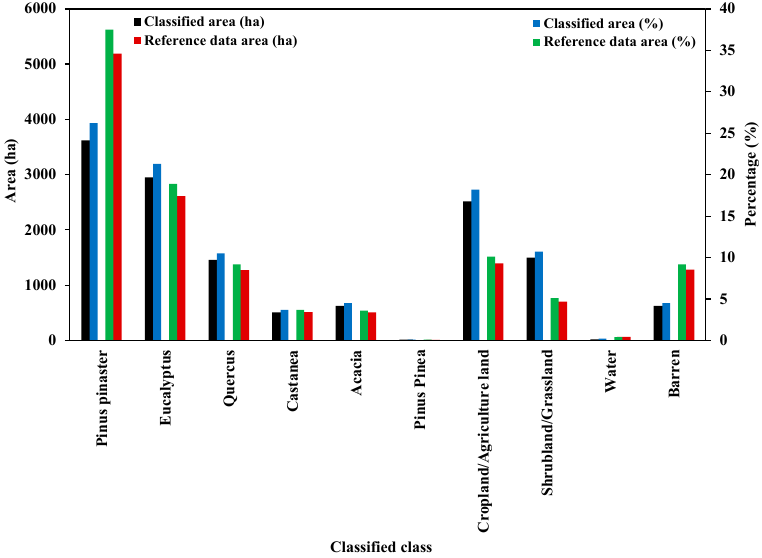
Figure 4. Comparison of classification result and reference data represented in total area (ha) and percentage of the whole study area.